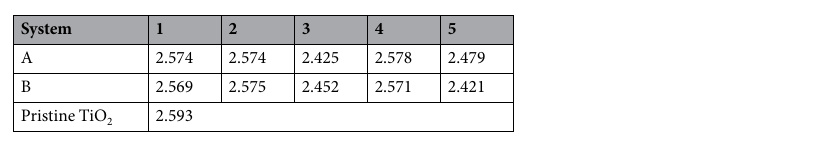
Table 3. The calculated bandgap (in eV) of TiO 2 after the adsorption of dyes with studied configurations.